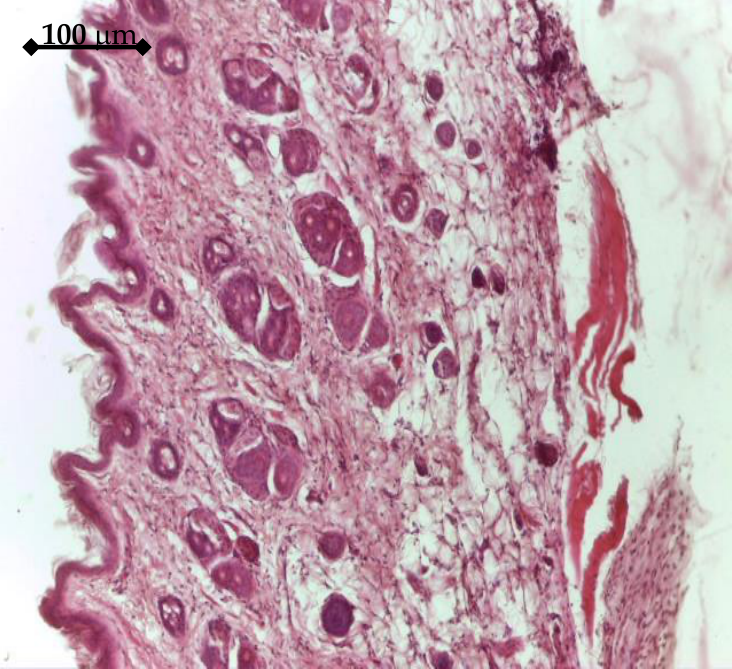
Figure 14. Tissue around Ti control sample (14 days), Hematoxylin eosin staining: tegument with thin epidermis, superficial and deep dermis, 10×.